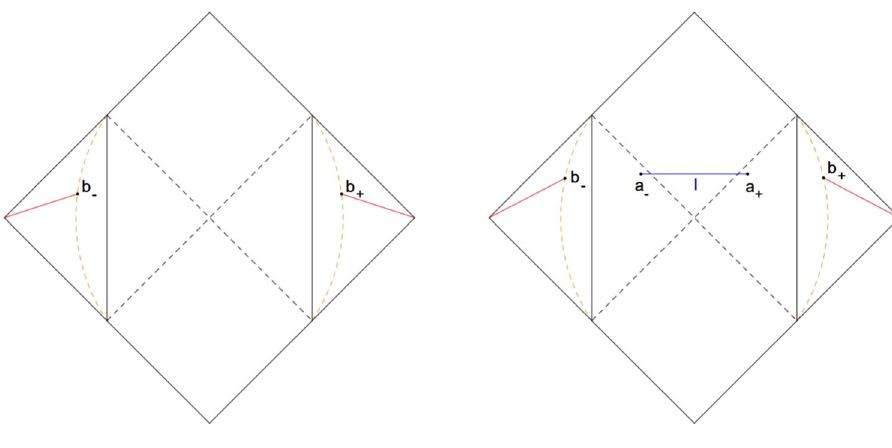
Fig. 1 Penrose diagram for the black hole coupled to a thermal bath. The bath can be viewed as a non-gravitational Minkowski spacetime a ± and b ± correspond to the boundaries of the island and the cutoff surface respectively